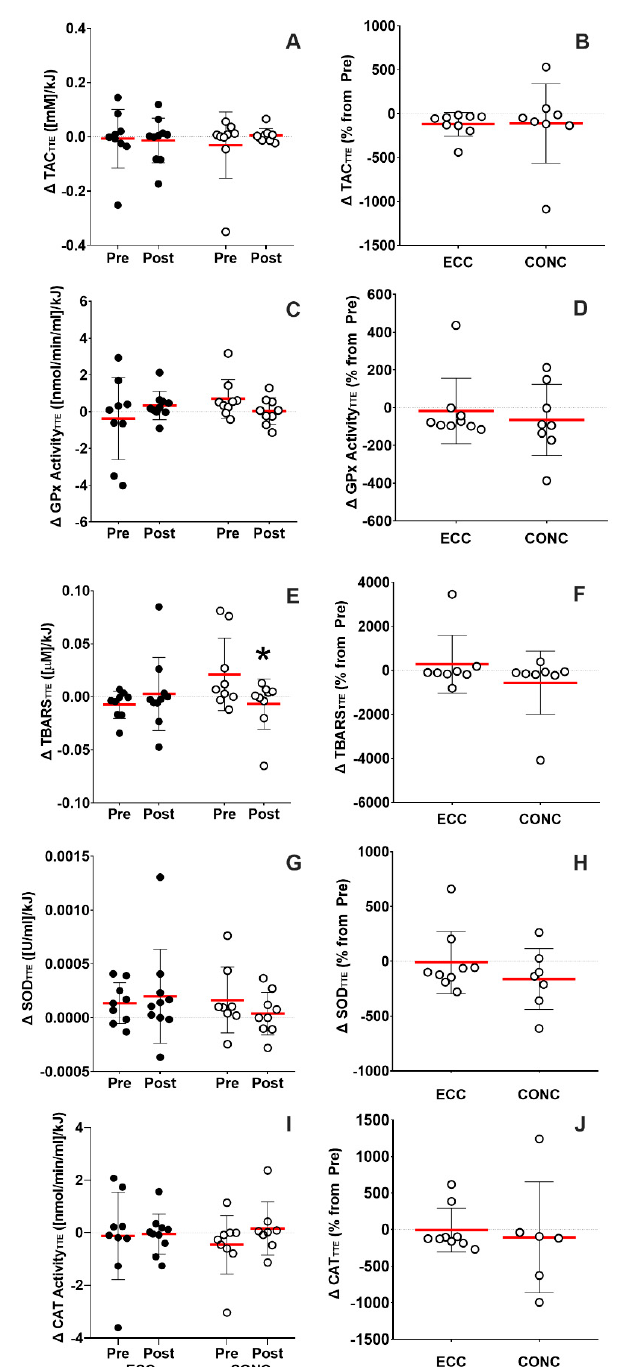
Figure 3. Oxidative stress markers change from rest to immediately following time to exhaustion test (TTE) normalized by the total workload during TTE. Absolute value changes in total antioxidant capacity (TAC TTE ) ( A ) and as a percentage of change from baseline ( B ). Absolute value changes in glutathione peroxidase activity (GPx TTE ) ( C ) and as a percentage of change from baseline ( D ). Absolute value changes in thiobarbituric acid reactive substances (TBARS TTE ) ( E ) and as a percentage of change from baseline ( F ). Absolute value changes in superoxide dismutase (SOD TTE ) ( G ) and as a percentage of change from baseline ( H ). Absolute value changes in catalase (CAT TTE ) ( I ) and as a percentage of change from baseline ( J ). ECC: eccentric cycling, CONC: concentric cycling. *: p < 0.05 vs.